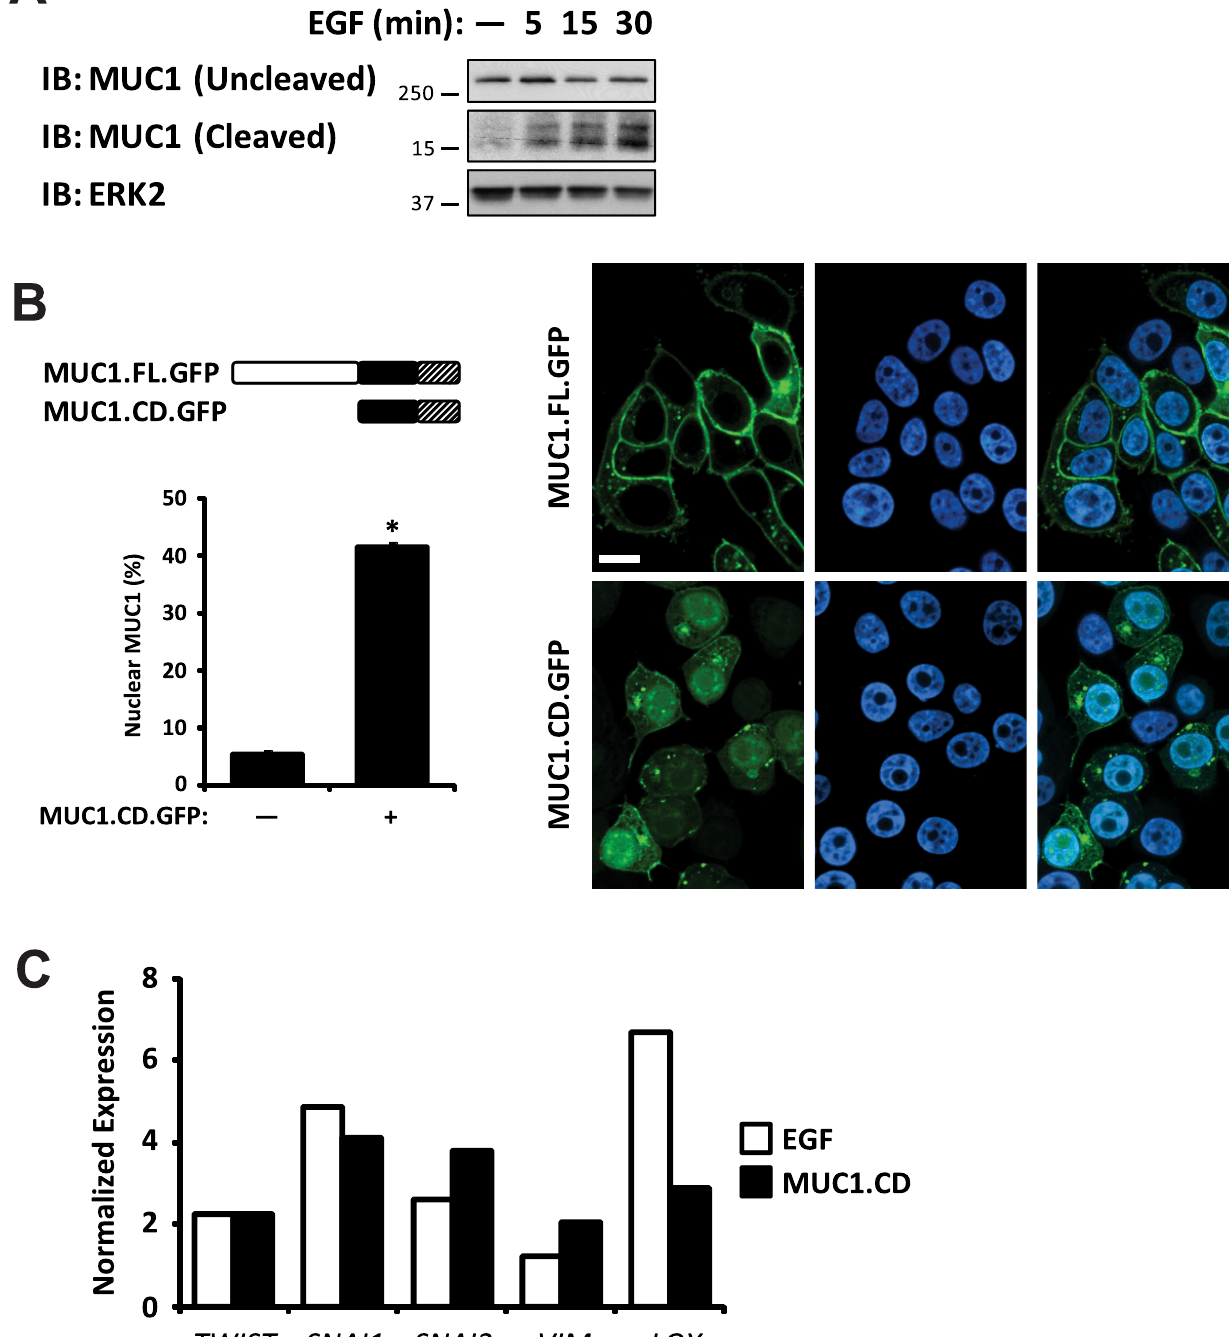
Figure 3. EGF enhances nuclear localization of MUC1 by regulating its cleavage. ( a ) Immunoblot detecting MUC1 cytoplasmic domain showing increased levels of cleavage product with EGF treatment in whole-cell lysates from FG cells. ( b ) Representative images of immunofluorescence of MUC1.FL and MUC1.CD fused to GFP (MUC1.FL.GFP and MUC1.CD.GFP, respectively; green); nuclei are counter-stained with TO-PRO-3 (blue). Schematics (left) illustrate MUC1.FL.GFP and MUC1.CD.GFP protein products including ectodomain (white), cytoplasmic domain (black) and GFP (hatched). Quantification of nuclear MUC1 (bar graph) is expressed as a percentage of total detectable MUC1. Scale bar represents 10 m m. * P , 0.0001 compared to cells expressing MUC1.FL.GFP. ( c ) Quantitative RT-PCR of FG cells treated for 15 minutes with EGF (white) or expressing MUC1.CD (black) compared to untreated or vector controls, respectively. For cells treated with EGF, peak expression changes over a 24 h period are reported. Values have been normalized to b -actin. Results are expressed as mean 6 s.e.m. Similar findings were observed in 3 independent experiments.